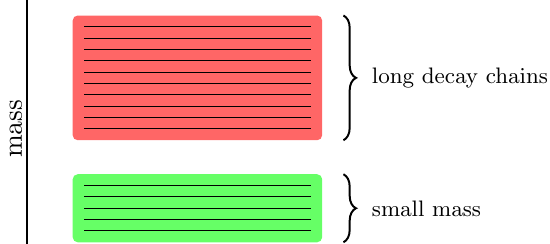
Figure 2. A theory with a moderately large number of new particles in a finite mass range, having a small coupling to the SM, is characterized by a few light states that decay directly to the SM and events with high multiplicities produced by the long decay chains of the heavier